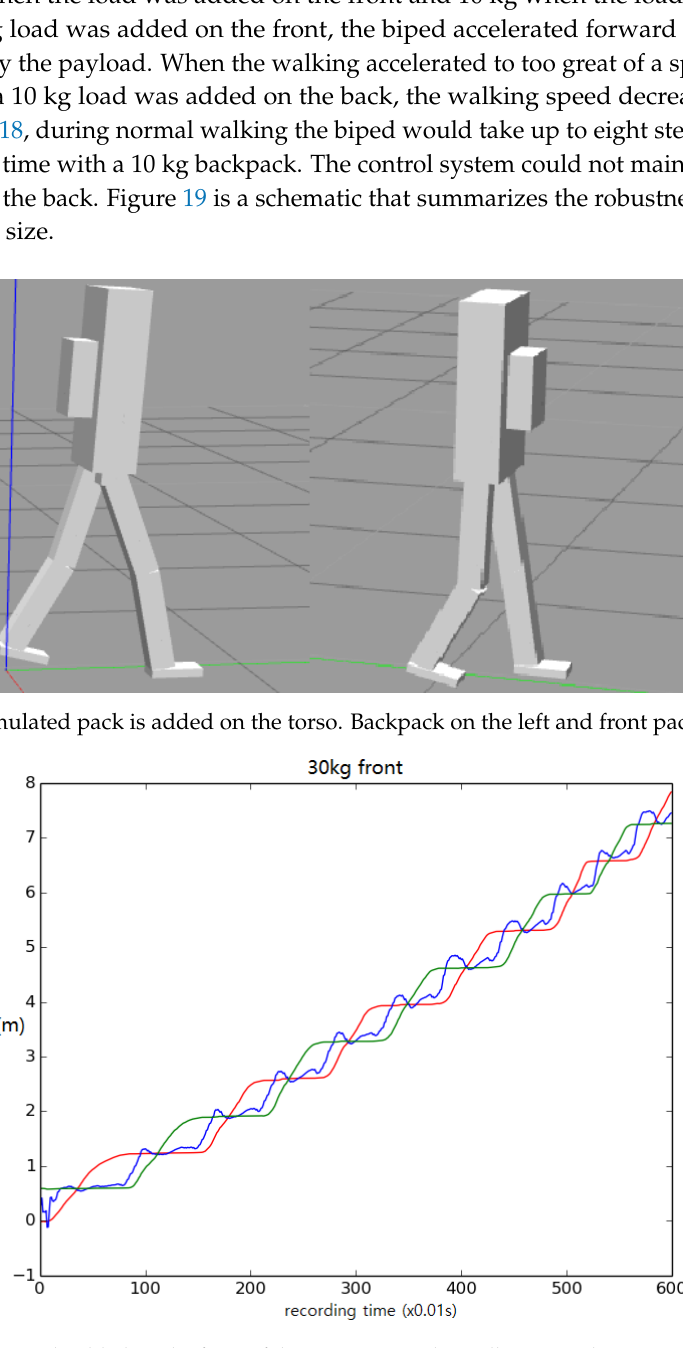
Figure 17. A 30 kg pack added on the front of the torso causes the walking speed to increase. The duration of each step gets shorter and the length of the stride increases. Walking distance versus